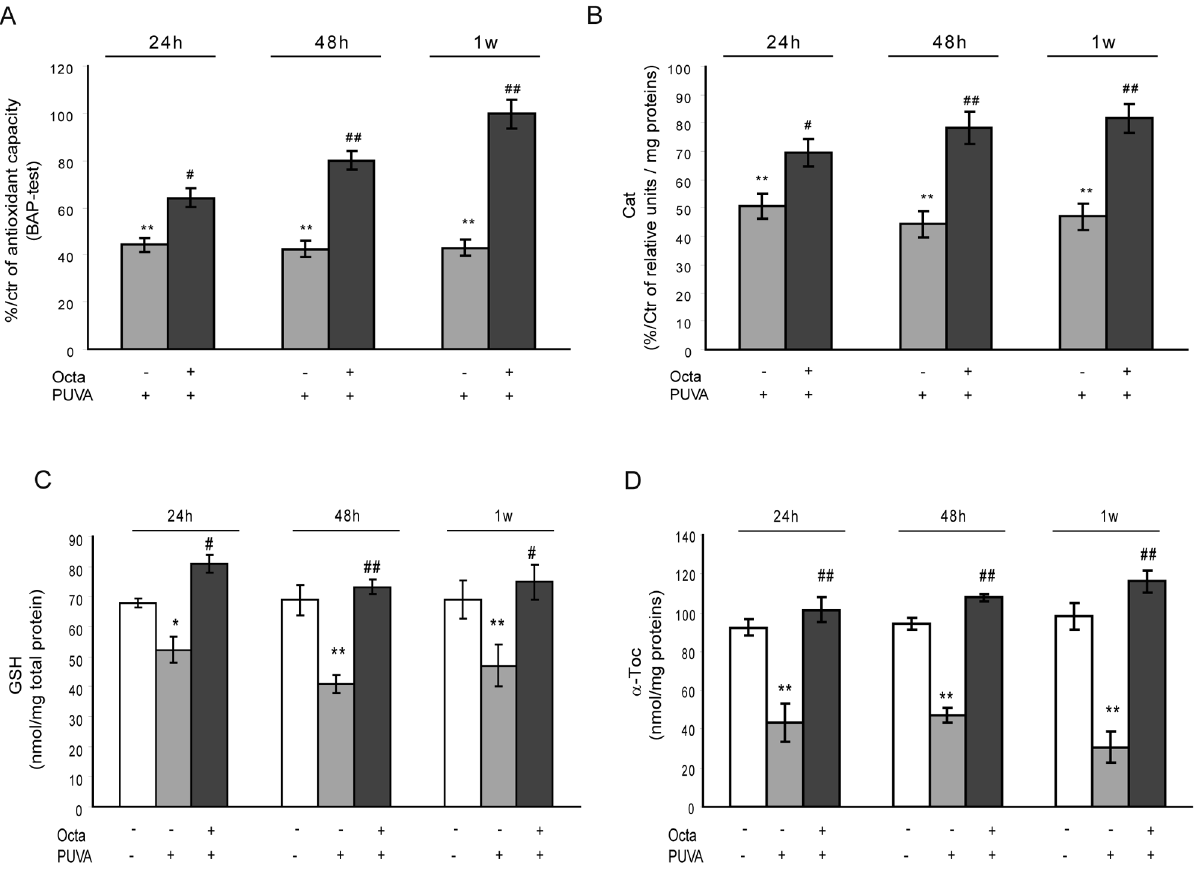
Figure 4. Protective action of PPAR c modulation on PUVA-induced imbalance of cell antioxidant system. HDFs (1 6 10 6 ) were lysed in PBS and protease inhibitor cocktail. Cell lysates were used for analytical determinations. (A) Total antioxidant capacity (TAC) was assessed by BAP-test as described under Materials and Methods section. (B) Cat enzyme activity was determined by spectrophotometry as described under Materials and Methods . (C) GSH concentrations were determined by HPLC-MS as described in Materials and Methods . (D) a -Toc is measured by GC-MS as described in Materials and Methods . *p , 0.05; **p , 0.001 respect to control fibroblasts; # p , 0.05; ## p , 0.001 compared with PUVA-treated